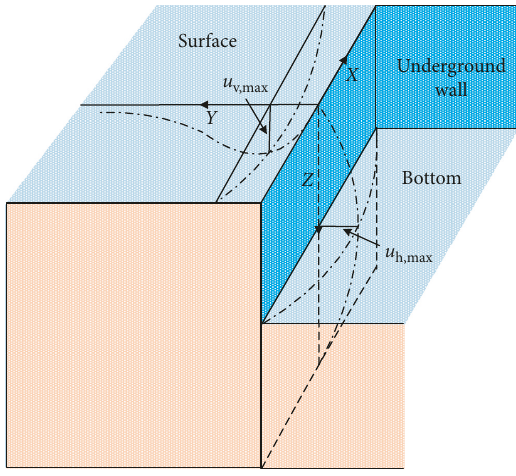
Figure 1: Soil movements adjacent to pit caused by